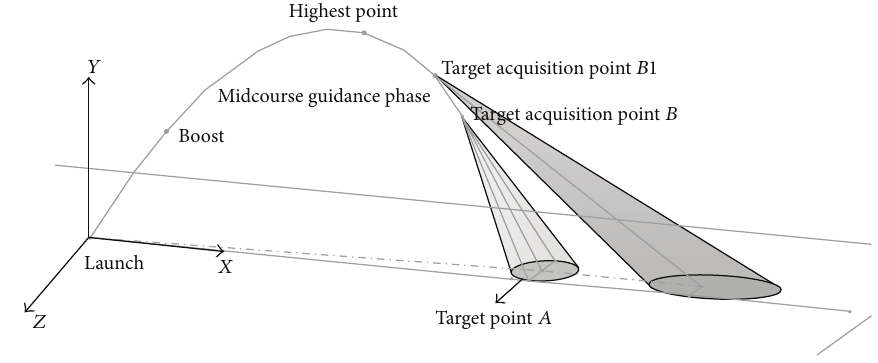
Figure 2: Different position of the target acquisition